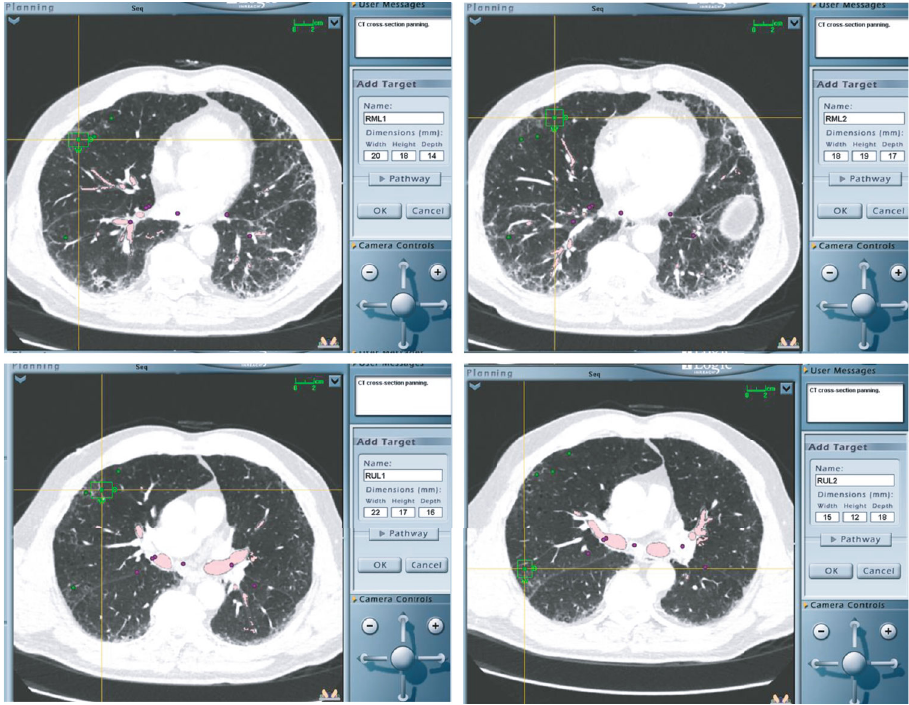
Figure 3: Preprocedure mapping for case 2 using the Medtronic superDimension Navigation System, version 7, Minneapolis, USA. Two targets were premarked in RML and two in the right upper lobe (RUL).